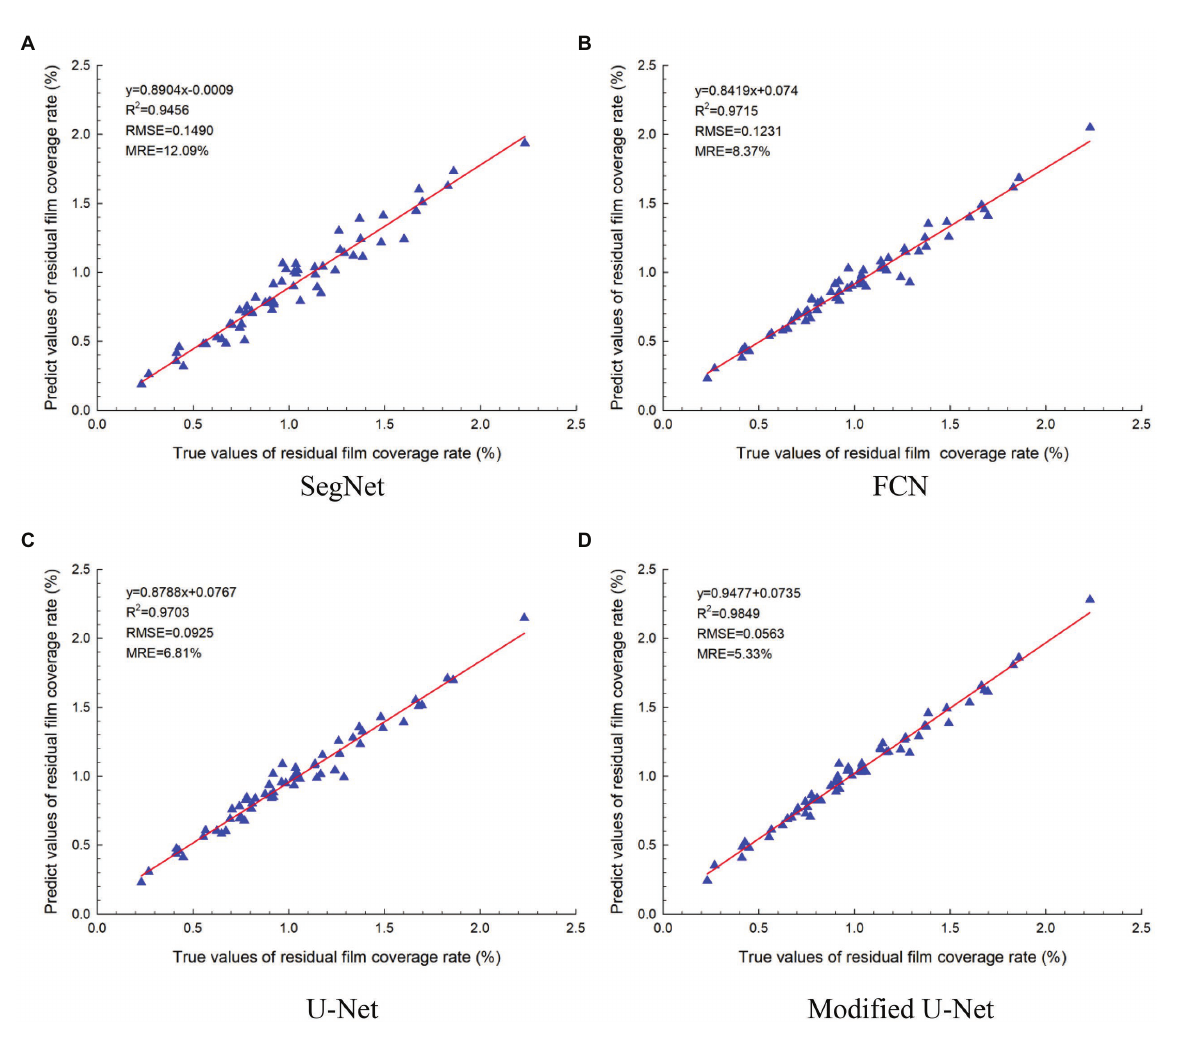
FIGURE 10 Regression analysis results of the UAV images-based evaluation and manual evaluation: (A) SegNet; (B) FCN; (C) U-Net; (D) Modified U-Net.